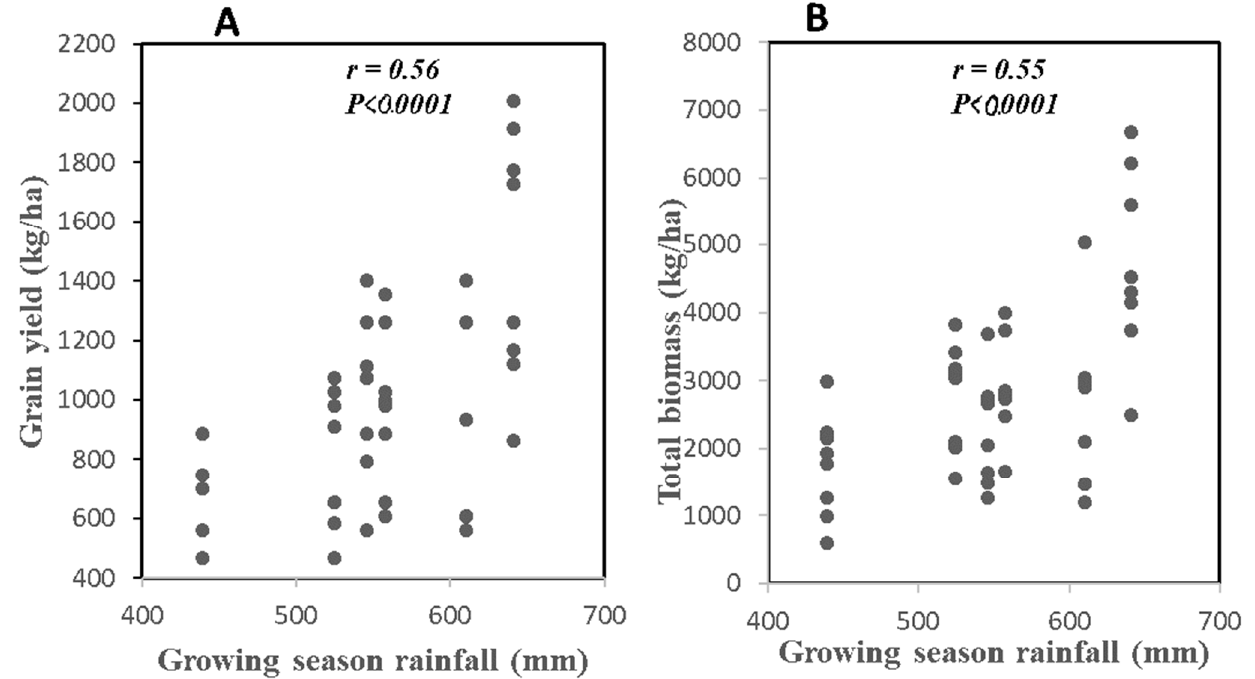
Figure 6. Scatter plots of grain yield ( A ), total plant biomass ( B ), and growing season rainfall from planting to harvest for the different study sites. The points represent the average of six replicates.